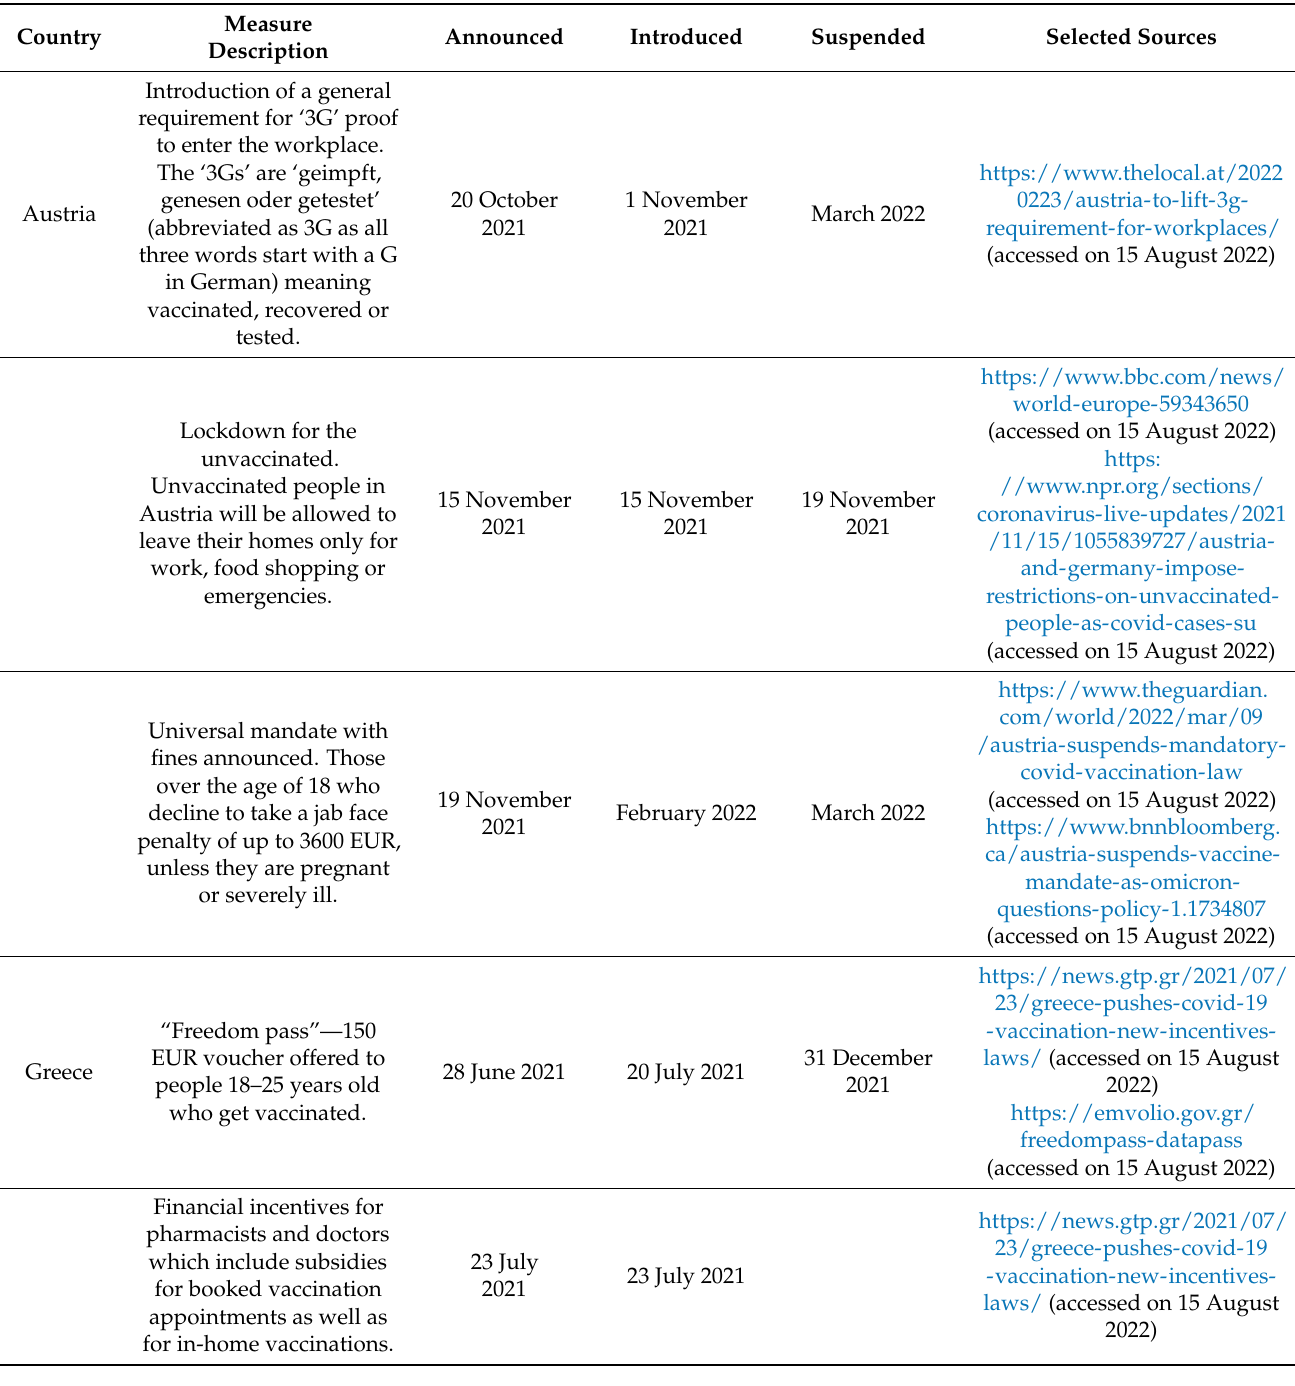
Table 1. Summary of COVID-19 vaccination mandates and incentives in the selected